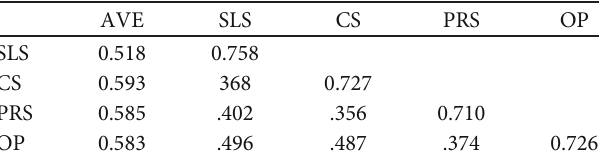
F IGURE 1: AMOS output of the structural model.